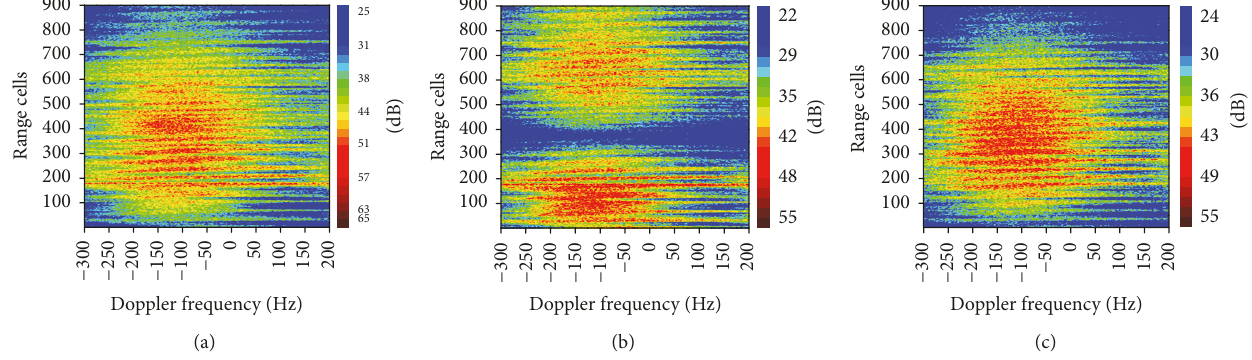
Figure 20: Examples of range Doppler maps, the first time burst: (a) sum channel. (b) Elevation difference channel. (c) Azimuth difference